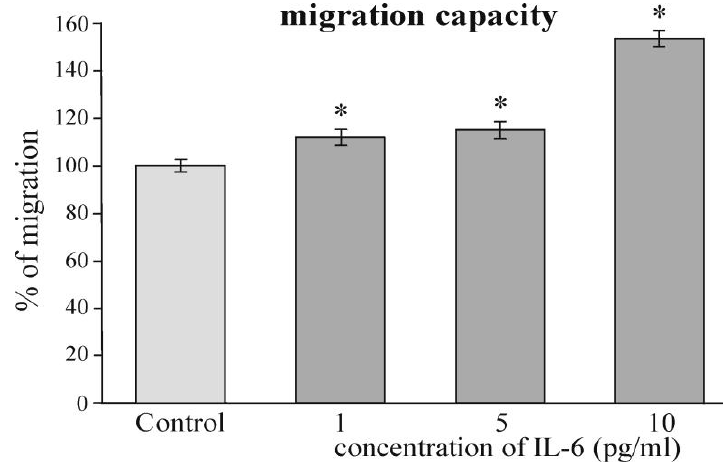
Figure 4. The effects of IL-6 on migratory potential of JEG-3 cells after 72 h of treatment under chemically induced hypoxia. Results are presented as the mean of three independent experiments ± standard error * p <0.05 relative to